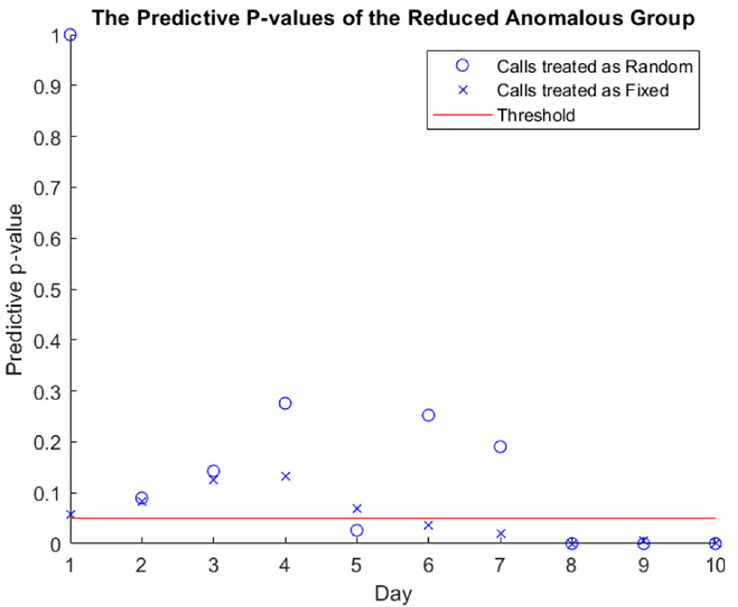
Fig 15. The p-values of the anomalous nodes under the multinomial